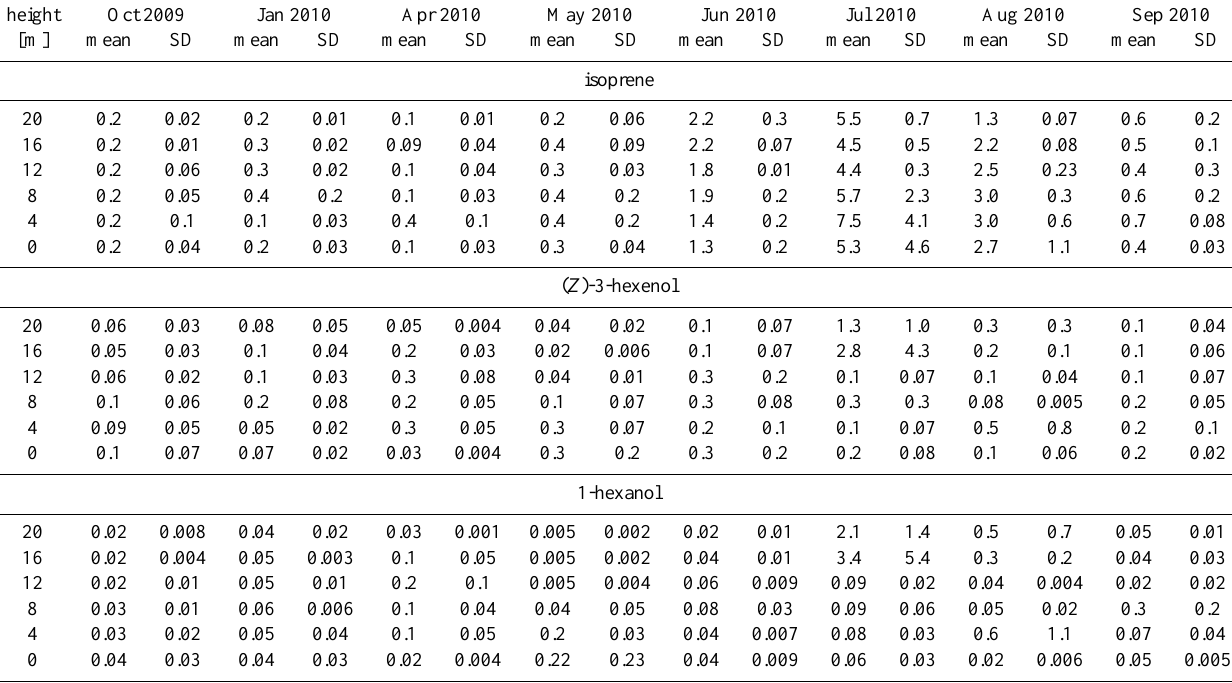
Table 2. Seasonal ambient isoprene and plant stress signal compounds ( Z )-3-hexenol and 1-hexanol (LOX) measured on six heights through- out the canopy. Values are given as means and standard deviations (SD) in µgm − 3